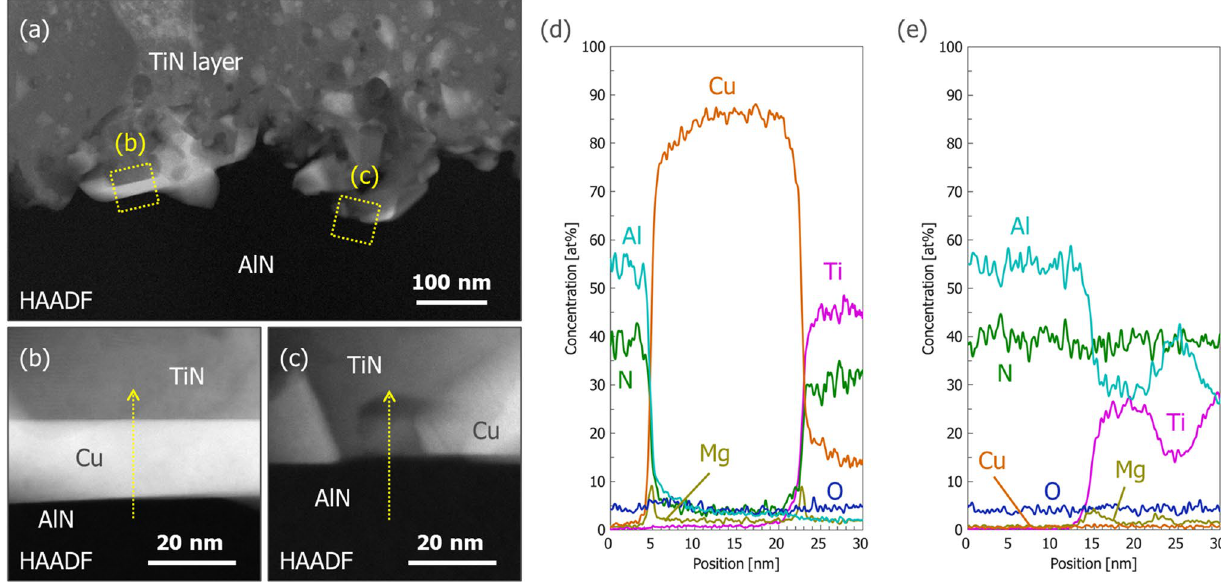
Fig. 10 a – c Cross-sectional HAADF images of a TiN layer/AlN interface bonded at 800 ℃ for 0.5 h. w Mg and w Ti were 1.04 mg/cm 2 and 0.45 mg/cm 2 , respectively. Line EDS profiles of d TiN/AlN indirect interface and e TiN/AlN direct interface. The yellow dotted arrow shown in ( b , c ) corresponds to the position from which the line EDS profiles in ( d , e ) were